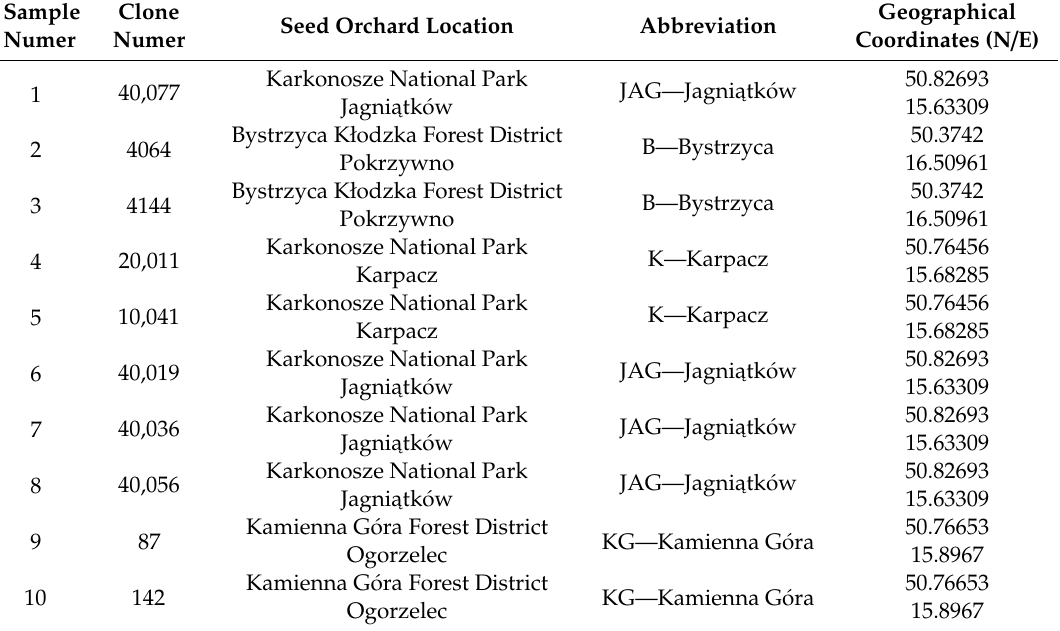
Table 1. List of localities of the studied Abies alba